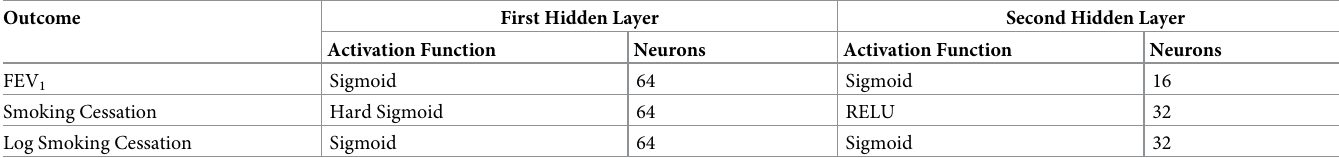
Table 2. Best neural network model features for predicting the different outcomes, determined by testing different combinations of activation functions, number of layers, and number of neurons per layer for each data set.